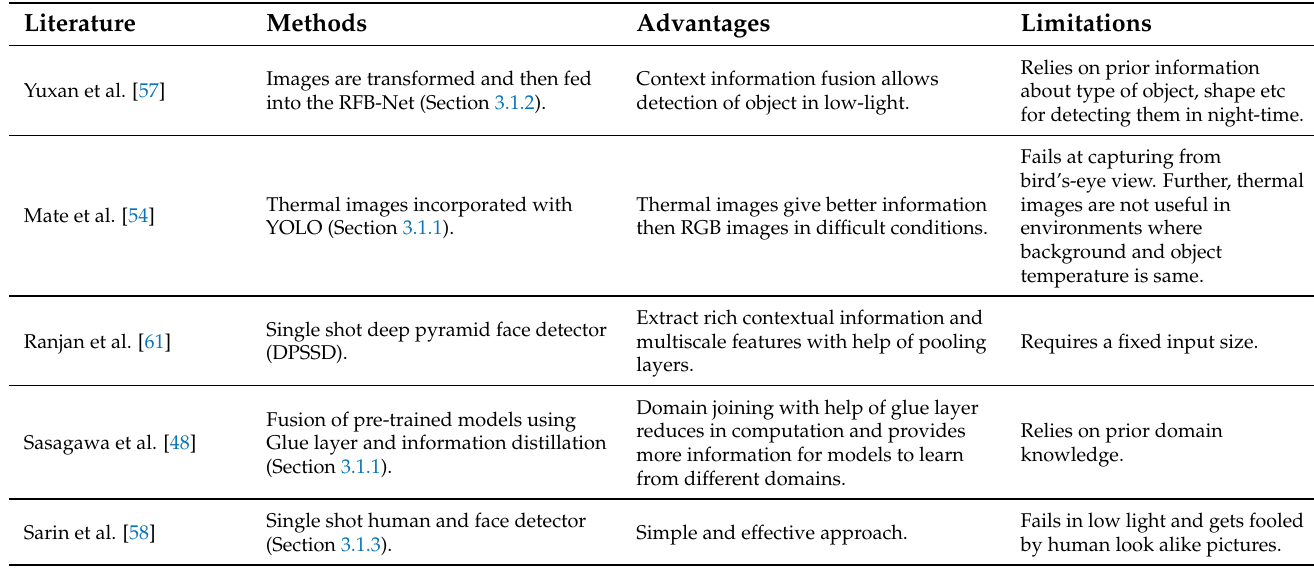
Table 1. A summary of advantages and limitations of methods tackling object detection in challenging environments. The double horizontal line separates the approaches according to the categories explained in Section 3.